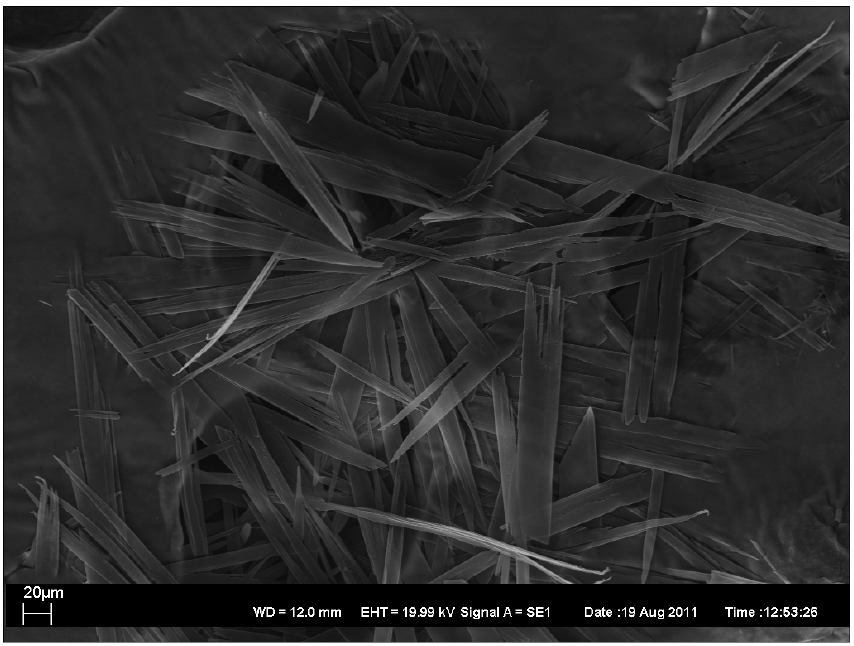
Figure 2. SEM image of xerogel from 1:1 EtOH/water 1%